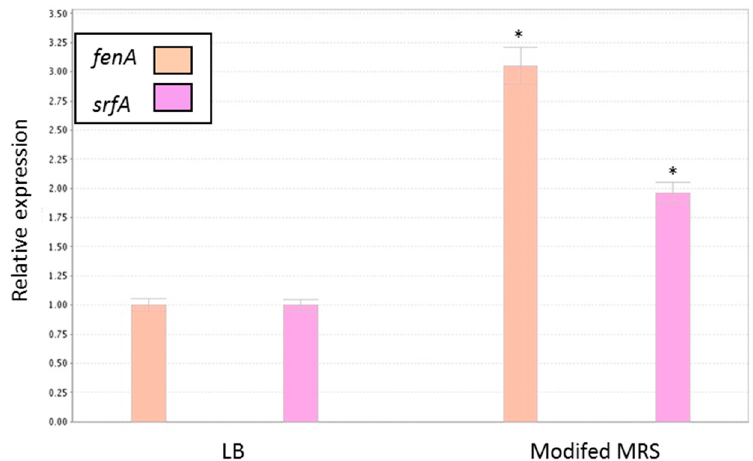
Figure 9. Relative expression of B. subtilis genes related to antagonistic activity during growth in the different media. The real-time (RT)-PCR analysis was performed for quantitation of fenA and srfA gene expression in B. subtilis cells grown in either LB or MMRS medium as described in the Methods. * p < 0.05 compared to control. Error bars represent standard deviation (SD).